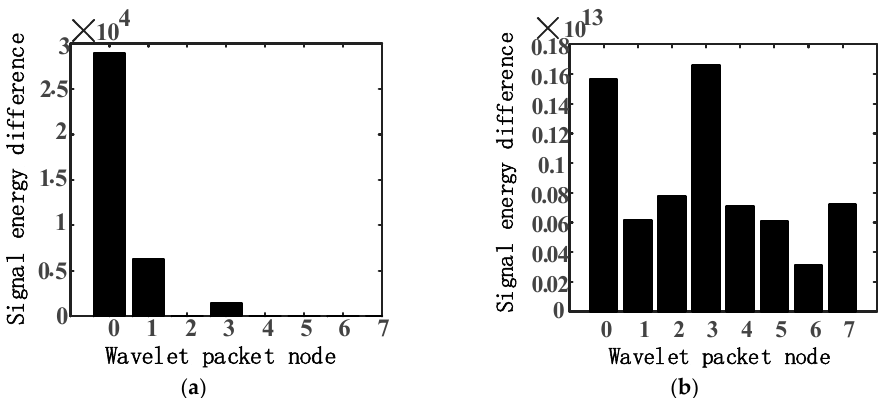
Figure 5. Wavelet packet node energy difference diagrams of the normal motor and the broken bar fault motor. ( a ) Current signal; ( b ) radial electromagnetic force signal.